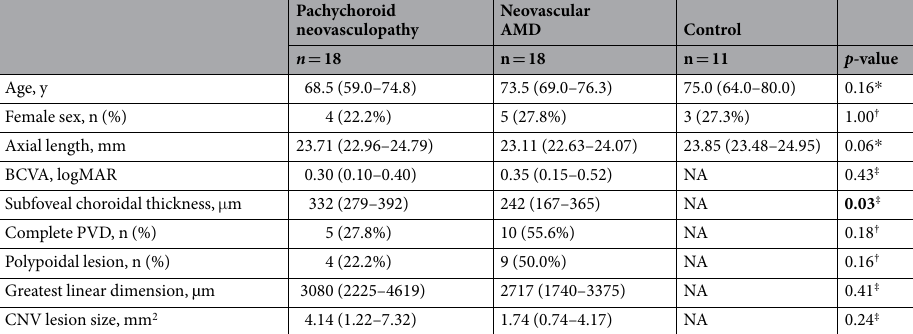
Table 1. Demographic and Clinical Characteristics among the Three Groups. Values are the median (interquartile range). P < 0.05 was considered significant (bold). * Kruskal-Wallis test. † Fisher’s exact test. ‡ Wilcoxon signed-rank test. NA = not available. AMD = age-related macular degeneration; BCVA = best- corrected visual acuity; CNV = choroidal neovascularisation; logMAR = logarithm of the minimal angle of resolution; PVD = posterior vitreous